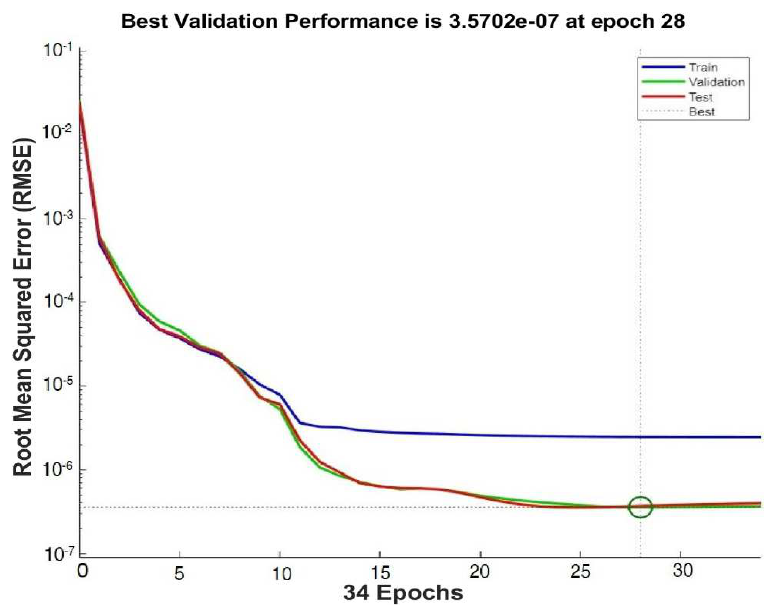
Figure 7. Performance plot for the best RMSE case.